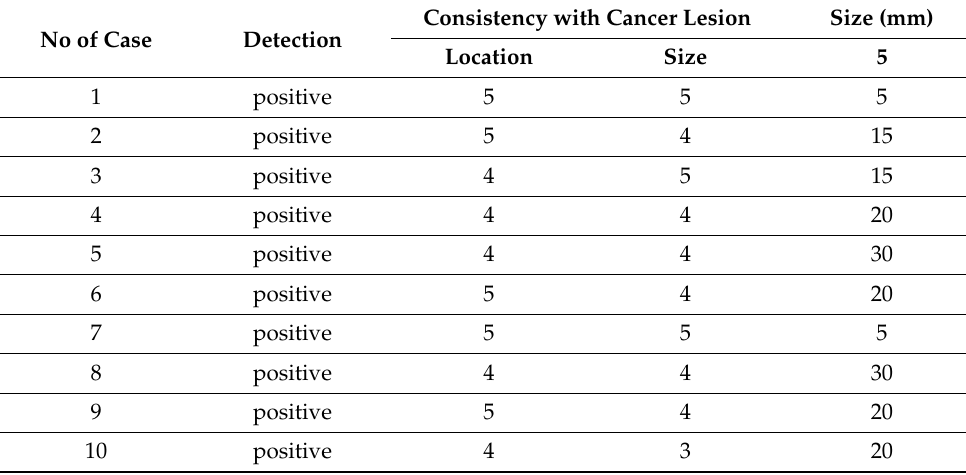
Table 3 lists the microwave imaging findings. The microwave imaging system detected breast cancer in all nine cases (100%). The median score of concordance between microwave imaging and breast cancer lesions was 4.5 (range, 4–5) or lesion location and 4.0 (range, 3–5) for lesion size. From the images created, the size of the tumor on the device was described, albeit in approximate size in Table 4. Median lesion diameter on microwave images was 20 mm (range, 5–30 mm). The maximum diameter was measured for those drawn in multiples, and the maximum diameter of the aggregated ones was measured for those in which small ones existed together. Figure 5 shows the positional relationship between the device and the breast. Representative cases are shown in Figure 5 (Case 6) and Figure 6 (Case 8). Table 3. Characteristics of microwave